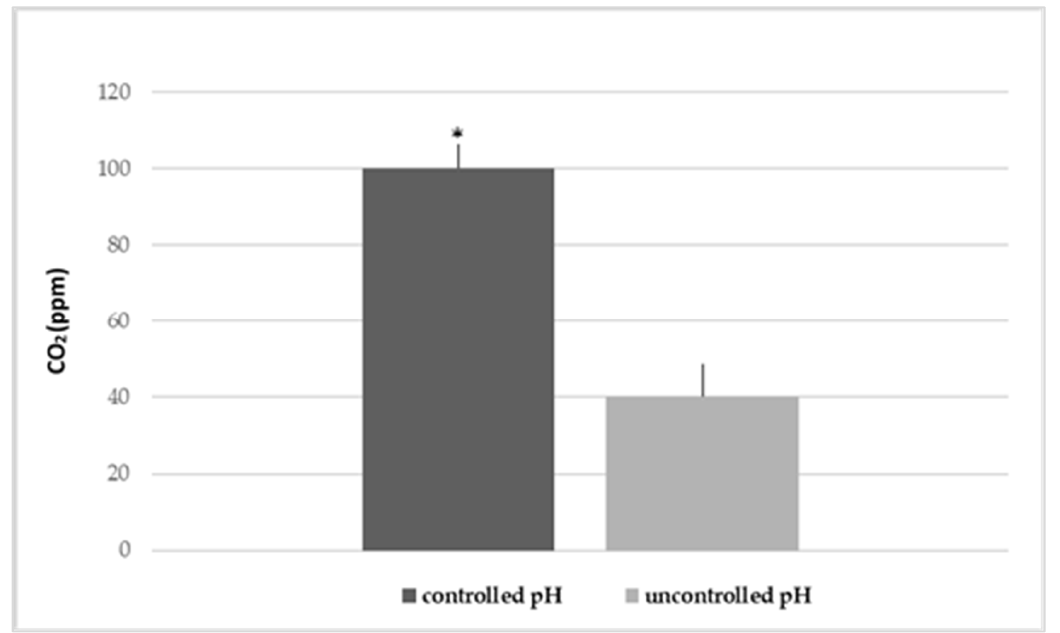
Figure 5. Mean DIC (CO 2 ppm) and standard error at the end of the three experimental weeks. Statistical significant differences ( p < 0.05) are shown by asterisks (*).